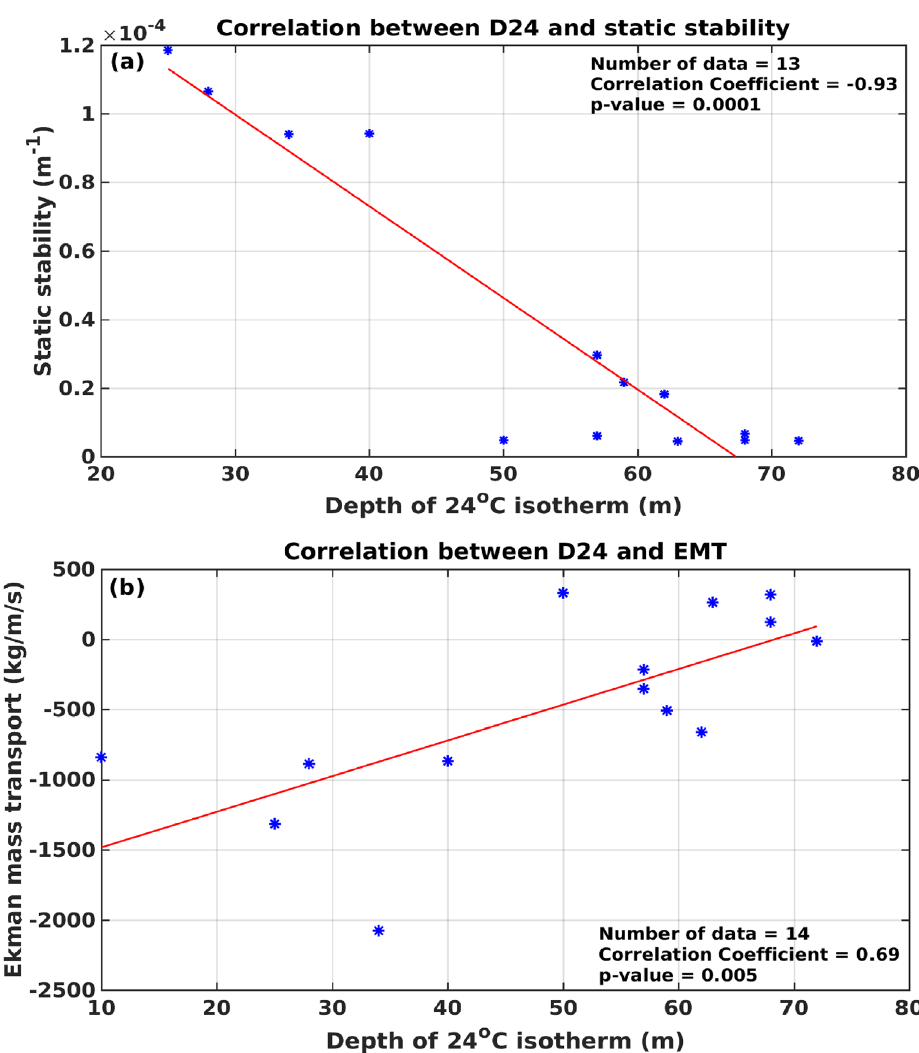
Figure 7. Correlation of depth of 24 °C isotherm (D 24 , m) with ( a ) static stability (m −1 ) in the upper 15 m of the water column, and ( b ) Ekman mass transport (EMT) (kg/m/s). All parameters were taken at 14 stations from 8° to 21°